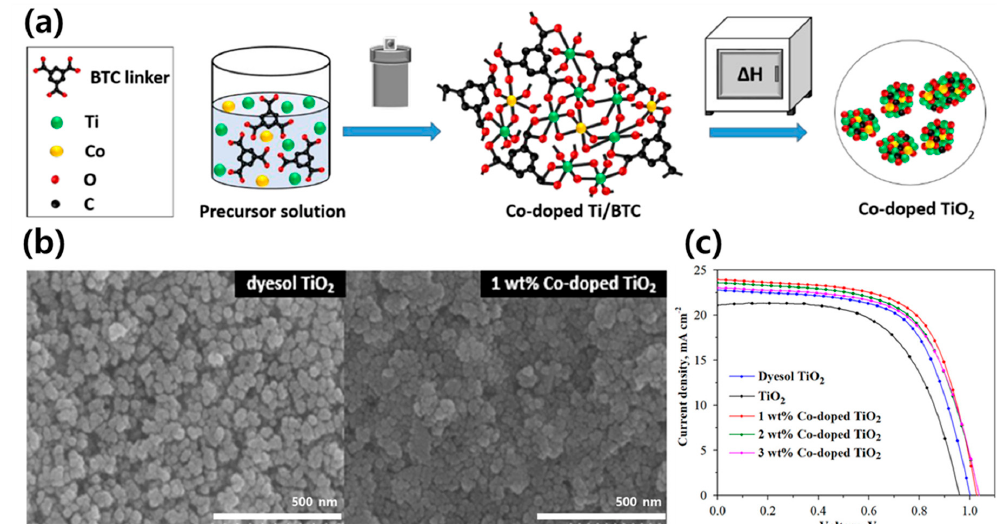
Figure 8. ( a ) Schematic of the preparation of Co-doped TiO 2 particles (BTC: trimesic acid). ( b ) SEM images of dyesol TiO 2 and 1 wt % Co-doped TiO 2 paste on FTO-coated glass. ( c ) current density–voltage ( J – V ) curves of the best performing PSCs using dyesol TiO 2 , undoped TiO 2 , and Co-doped TiO 2 (1, 2, and 3 wt %). Reprinted from [118] with permission.